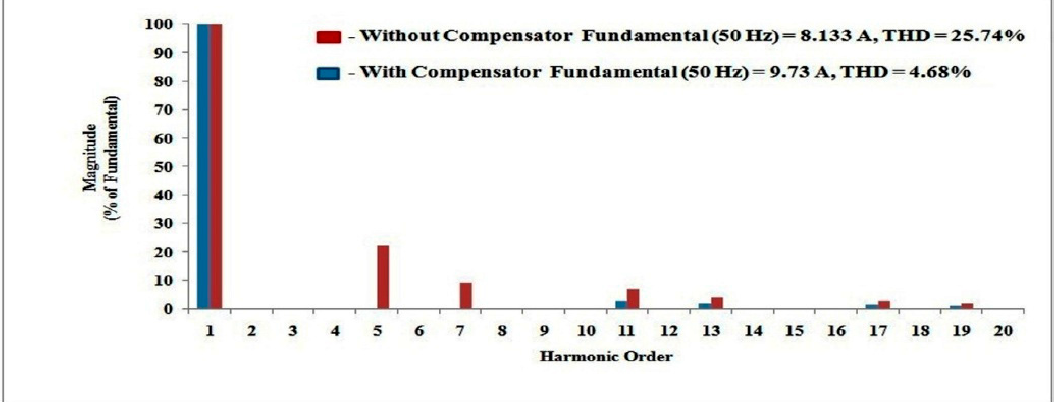
Figure 5. FFT analysis of the supply current with and without compensator.